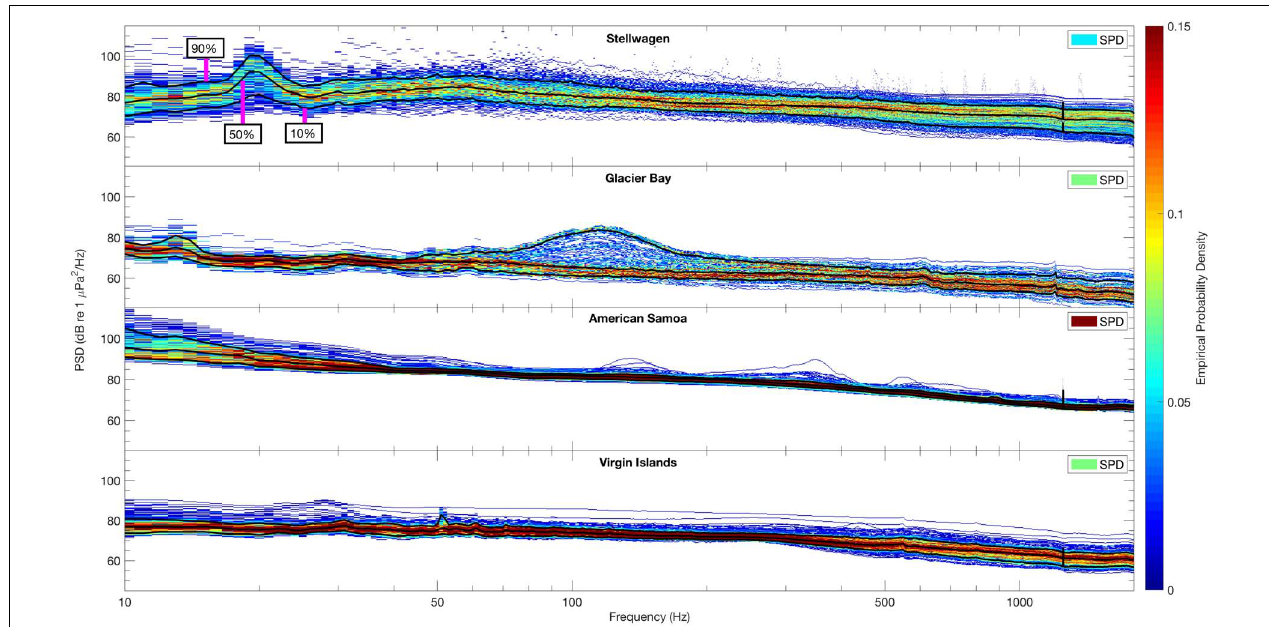
FIGURE 4 | Spectral probability density (SPD; Merchant et al., 2013) plots of the distribution of sound levels (10 Hz–2 kHz) across sites for all available data (see Table 1 ). Solid black lines indicate percentile levels [90th, 50th (median), 10th] of power spectral densities (PSD, dB re 1 µ Pa 2 /Hz). PSD sound levels of each frequency band determine the empirical probability density (EPD), indicated by z -axis color bar range of blue (lower probability) to red (higher probability). An overall SPD is also calculated for each site (upper right corner of each panel) indicating the overall probability of temporal sound level